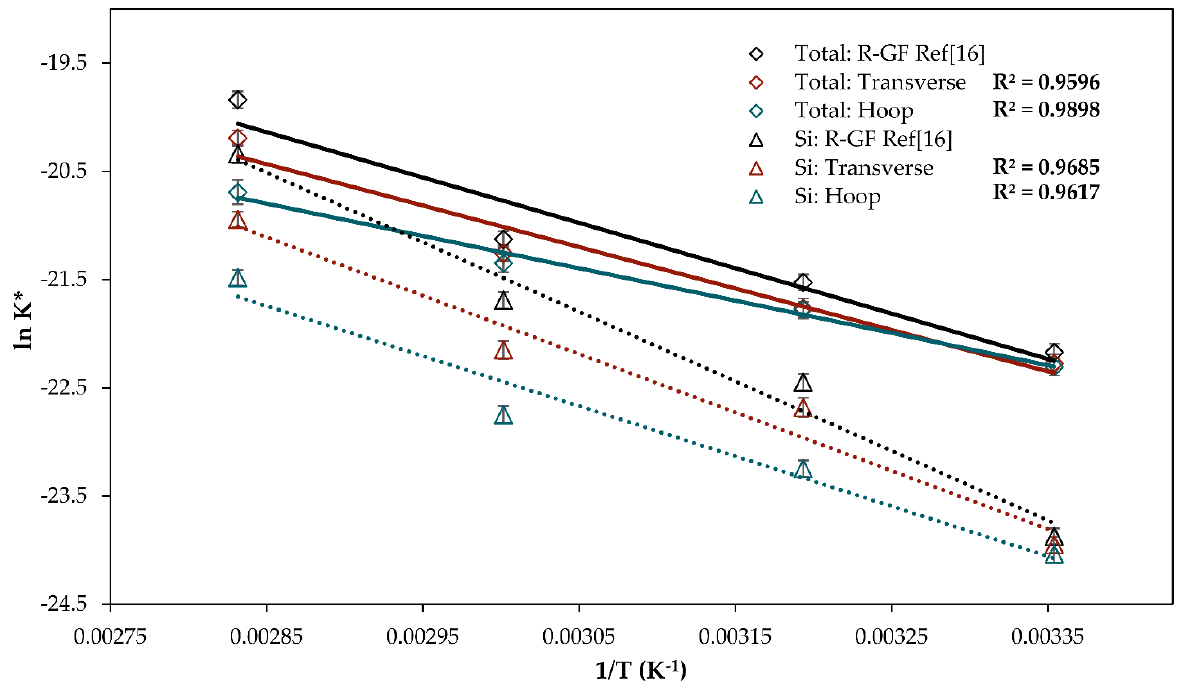
Figure 9. Graphing approach to obtain the pre-exponential factors and activation energies of Si and total glass dissolution for GFRPs at pH 5.65 and 60 °C compared with unencapsulated R-GF data reported in [16].